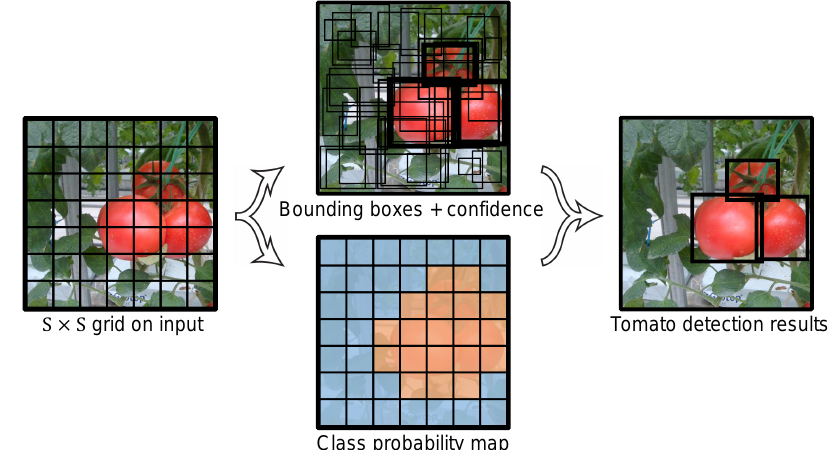
Figure 1. YOLO model